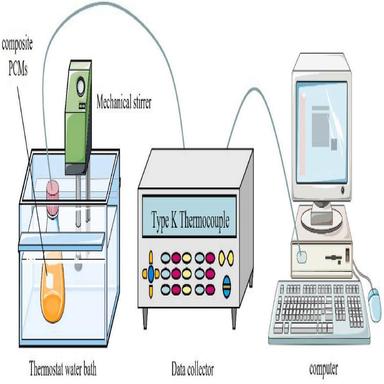
The equipment of T-history test method.